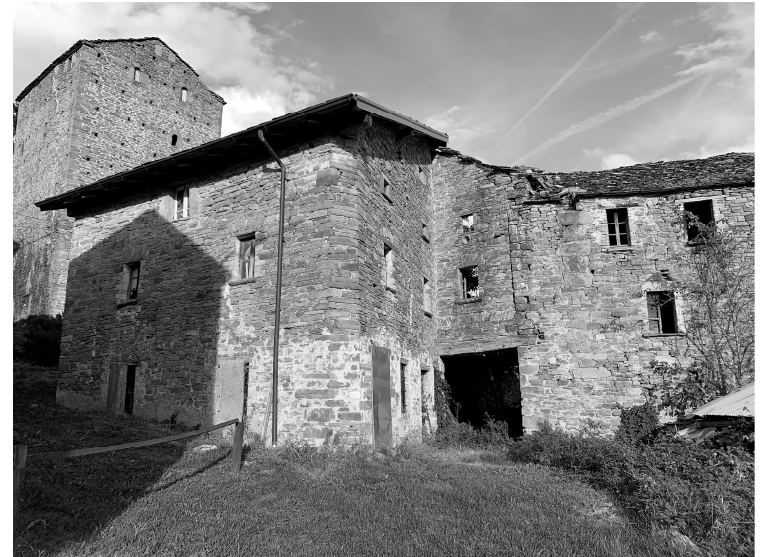
Figure 2. Few abandoned buildings in the village of Ebbio. Source: Fondazione Ebbbio.